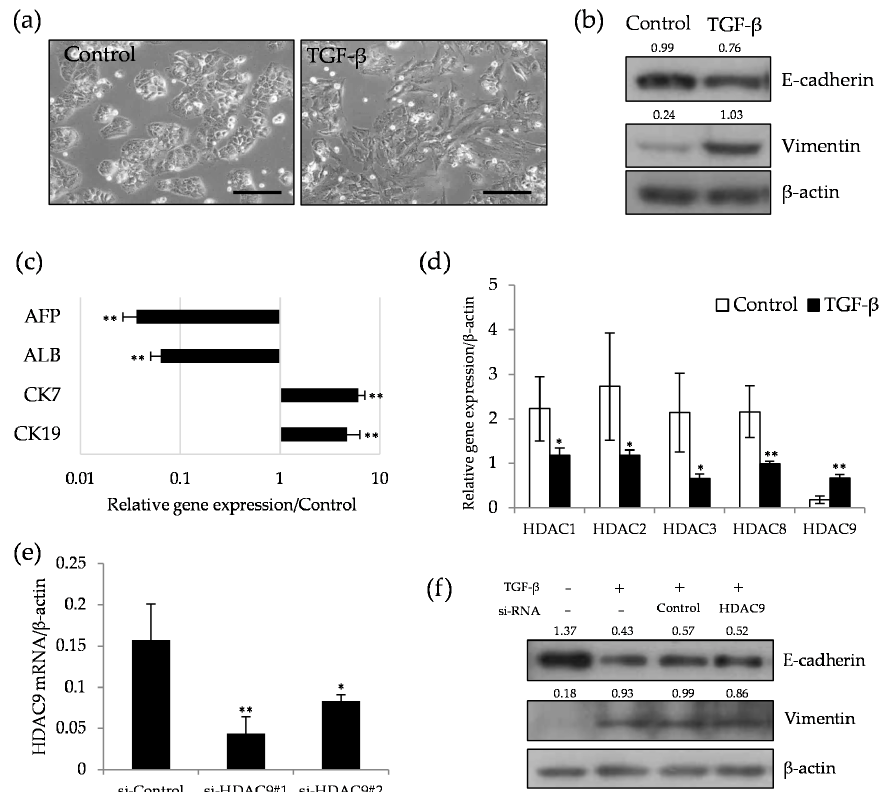
Figure 2. Selective induction of HDAC9 in transforming growth factor- β (TGF- β )-induced epithelial– mesenchymal transition (EMT) in differentiated HCC cells. ( a ) Microscopic observation of HuH1 cells treated with control vehicle ( left ) and 10 ng/mL of TGF- β ( right ) for 48 h. Note the morphological change from epithelial to mesenchymal cell shape by TGF- β stimulation. Scale bar, 50 μ m. ( b ) Western blot analysis of E-cadherin, vimentin, and β -actin as a protein loading control. Relative protein expression levels of β -actin were calculated from the band intensity with ImageJ software (NIH) and described above each band. Uncropped western blot figures in Figure S4. ( c ) Quantitative PCR analysis of hepatic (alpha fetoprotein; AFP and albumin; ALB) and hepatic progenitor (keratin 7; CK7 and keratin 19; CK19) markers in TGF- β -treated cells. The values are expressed as relative expression compared to vehicle control group. ** p < 0.01 vs. the vehicle control. ( d ) Relative gene expression of HDACs to β -actin in HuH1 cells treated with control vehicle (open bar) and TGF- β (closed bar) for 48 hrs. * p < 0.05, ** p < 0.01 vs. the vehicle control. ( e ) HDAC9 transcript level in HLF cells transduced with si-RNA for negative control (si-control) and HDAC9 (si-HDAC9#1 and #2). * p < 0.05, ** p < 0.01 vs. si-control. ( f ) Western blotting of E-cadherin, vimentin in the cells treated with TGF- β and si-RNAs. Cells were pretreated with mock (lipofectamine), si-Control, and si-HDAC9#1 for 24 h and subsequently stimulated with TGF- β to induce EMT for 48 h. Cells without any treatment served as non-treated control. Quantitative PCR analysis was performed at n = 4. Western blot was performed at least three times, and the representative blot was shown. Uncropped western blot figures in Figure